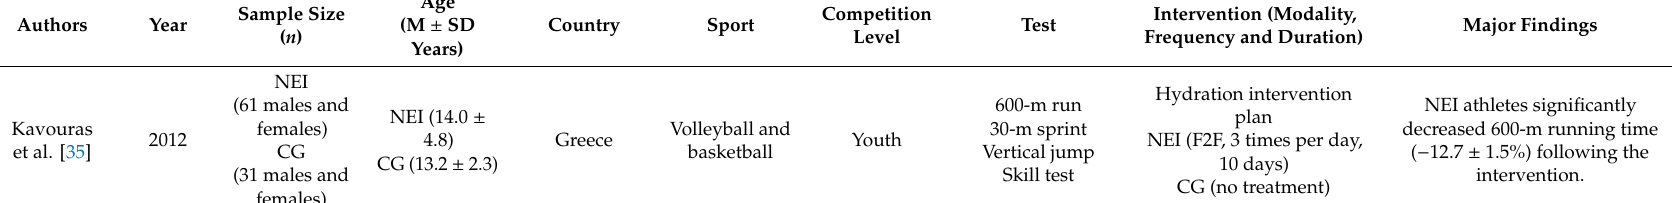
Table 4. Characteristics and major findings of the studies analyzing the e ff ect of nutrition education interventions on physical performance in team sport athletes.